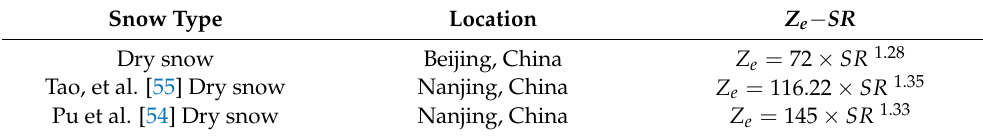
Table 5. The relationship of Z e − SR for snow.